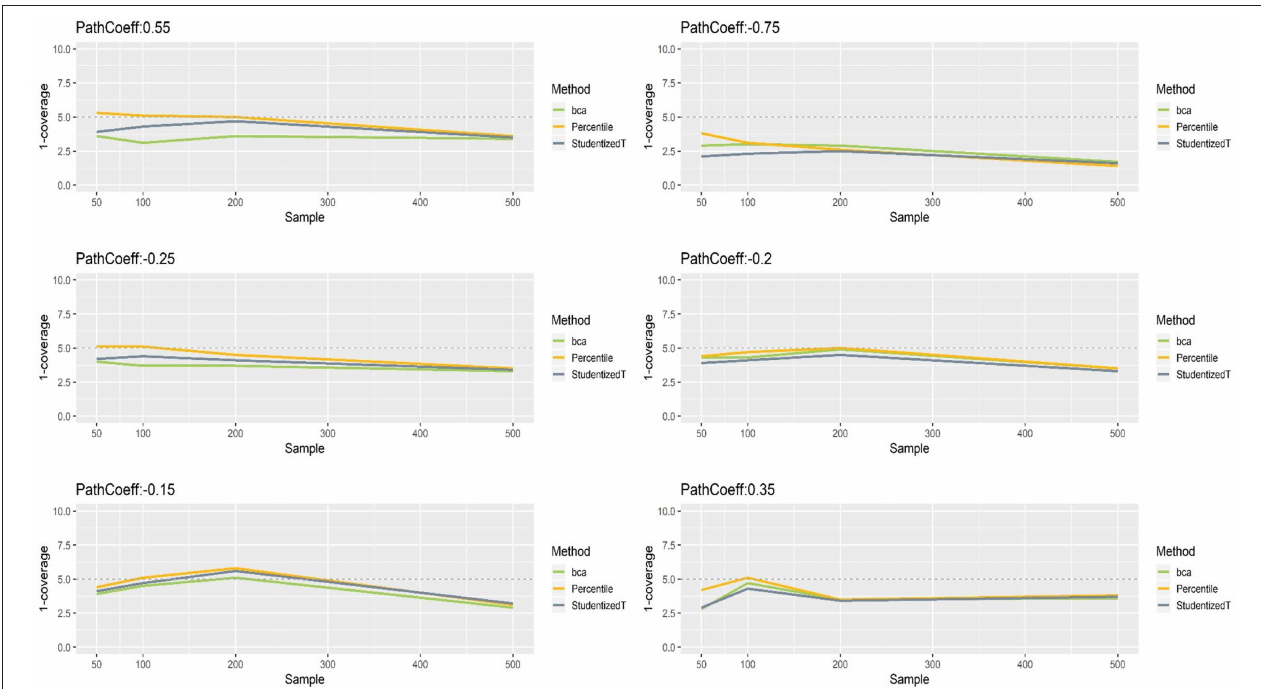
FIGURE 4 | The coverage of percentile, bias-corrected and accelerated bootstrap (BCa), and Student’s t 95% confidence intervals (CIs) of path coefficients in the normal indicator condition.